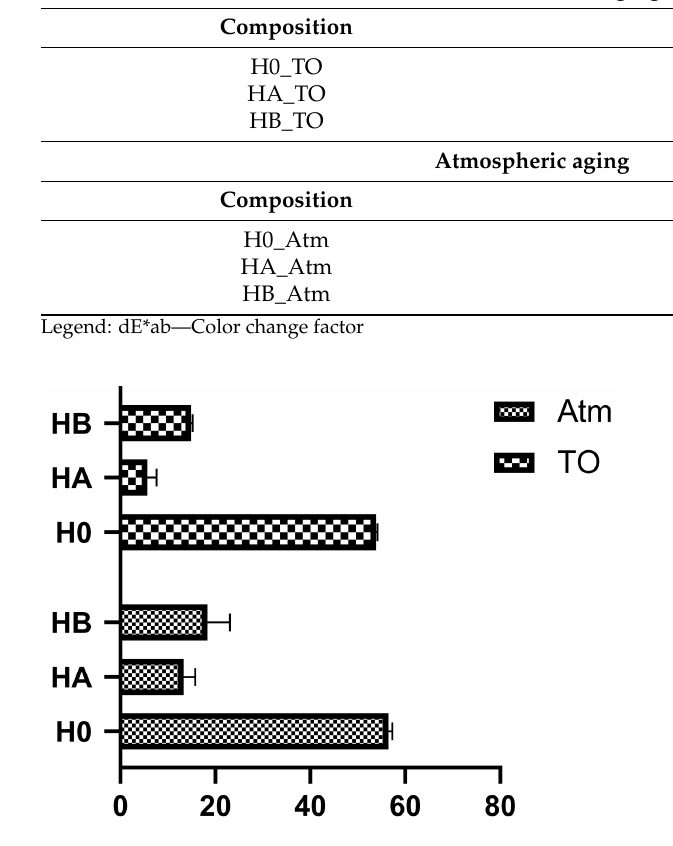
Figure 10. Comparison of color changes after aging of the